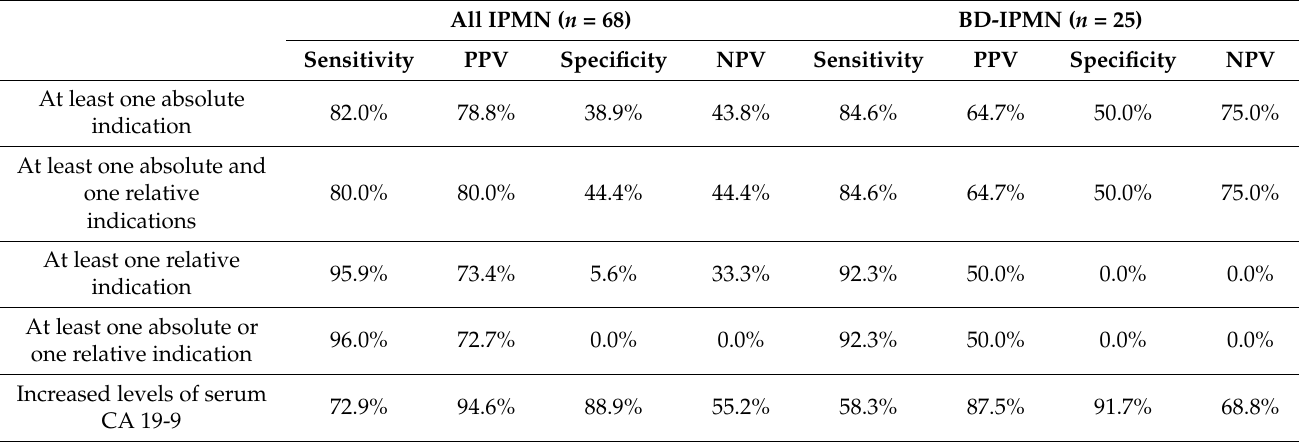
Table 5. Diagnostic performance of specified indications for resection according to the European evidence-based guidelines on pancreatic cystic neoplasms stratified by patients with intraductal papillary mucinous neoplasms and patients with branch duct-intraductal papillary mucinous